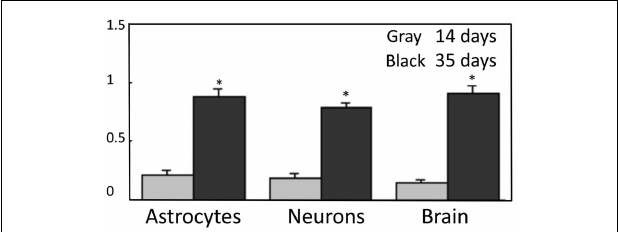
FIGURE 4 | Protein expression of aralar in neuronal and astrocytic cell fractions are similar and develop at identical rates . Neuronal and astrocytic cell fractions were gently isolated from two mouse strains, one expressing a neuronal marker with a specific fluorescence and the second expressing an astrocytic fluorescent signal (Lovatt et al., 2007). Samples were applied to slab gels of 12% polyacrylamide, separated by electrophoresis, and transferred to nitrocellulose membranes. After blocking with 5% skim milk powder and washing, these membranes were incubated for 2h at room temperature with the primary anti-aralar antibody sc-271056 (from Santa Cruz Biotechnology, CA, USA) after dilution (1 × 100), shown not to react with the related carrier citrin, and followed by incubation with a goat anti-mouse HRP-conjugated secondary antibody, also from Santa Cruz Biotechnology (dilution: 1 × 200) for 2h at room temperature. Anti β -actin (Sigma, St. Louis, MO, USA) was applied in the same lanes as the aralar antibody to use β -actin as a housekeeping protein providing an internal control for protein load.The intensities of both bands on the blots were scanned, and the ratios between aralar and β -actin were calculated and shown in the Figure. From Li et al.